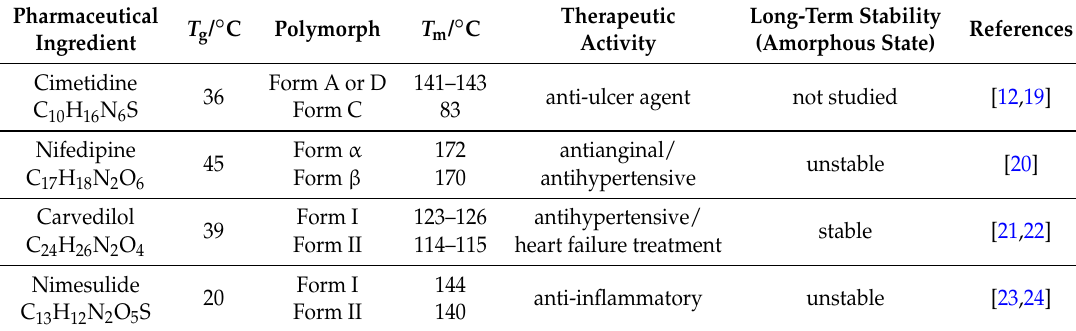
Table 1. Thermal properties, therapeutic activity and long-term stability of the amorphous state of active